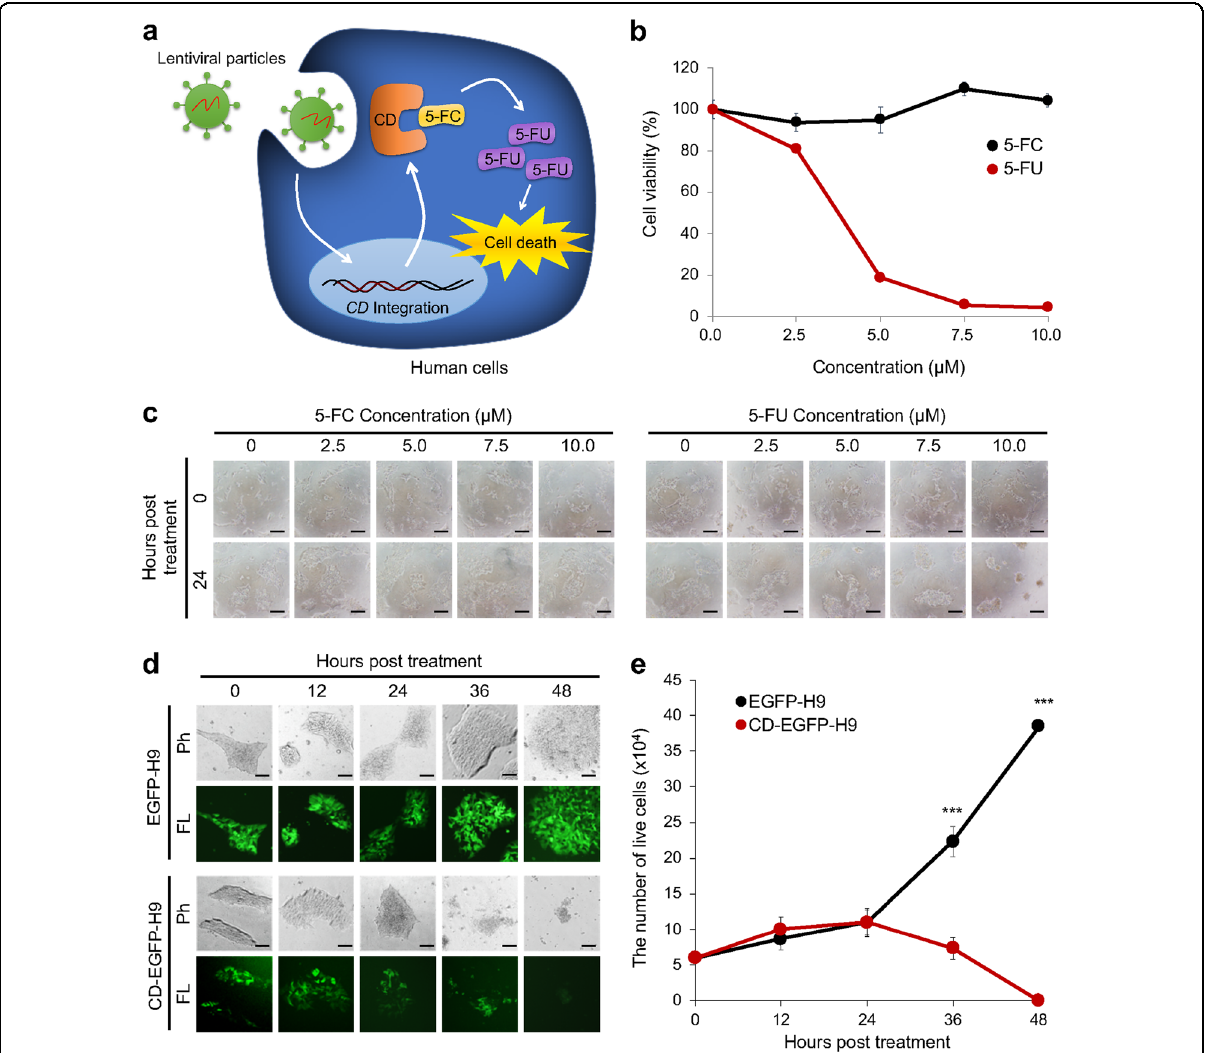
Fig. 1 Removal of CD gene-integrated human ESCs by 5-FC treatment. a A schematic of the cytotoxic effects of 5-FC treatment on CD- integrated cells is shown. Genomic integration was mediated by lentiviral transduction. b The viability of H9 human ESCs treated with varying concentrations of 5-FC and 5-FU was measured using a WST-1 assay. All values are normalized to controls (0 µM). This experiment was performed in triplicate. c Representative images of the morphology of H9 cells treated with 5-FC or 5-FU were randomly acquired at the indicated time points. Scale bars represent 50 µm. d Phase contrast (Ph) and fl uorescence (FL) images of EGFP-H9 and CD-EGFP-H9 cells were obtained every 12 h after treatment with 50 µM 5-FC. Scale bars represent 50 µm. e The number of live cells was counted every 12 h by trypan blue staining. This experiment was performed in triplicate. *** Represents P < 0.001 using Student ’ s t